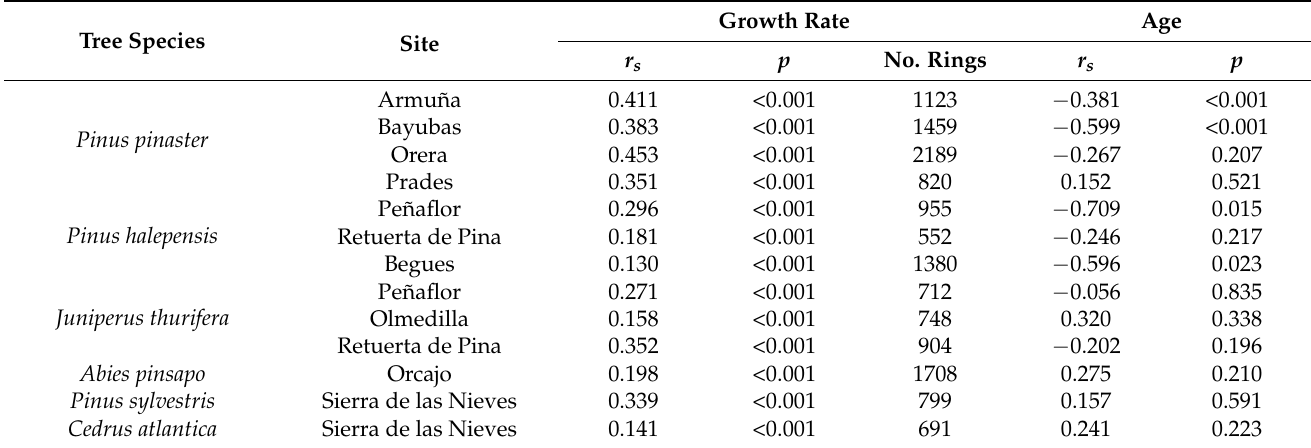
Table 3. Relationships observed between tree growth rate (tree-ring width) or age and the amount of IADFs produced by trees assessed using the Spearman correlation coefficient ( r s ) and its significance level ( p ). Note that the correlations between growth rate and IADF production were calculated considering all measured rings.